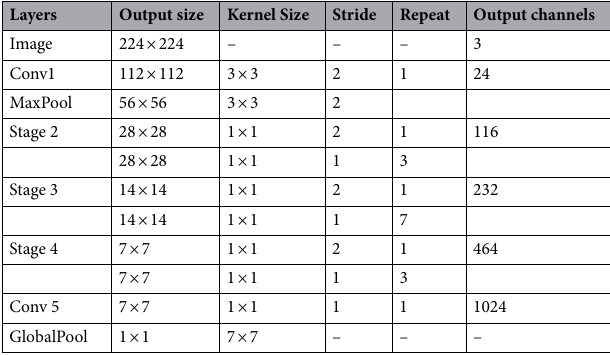
Table 1. ShuffleNetV2 network